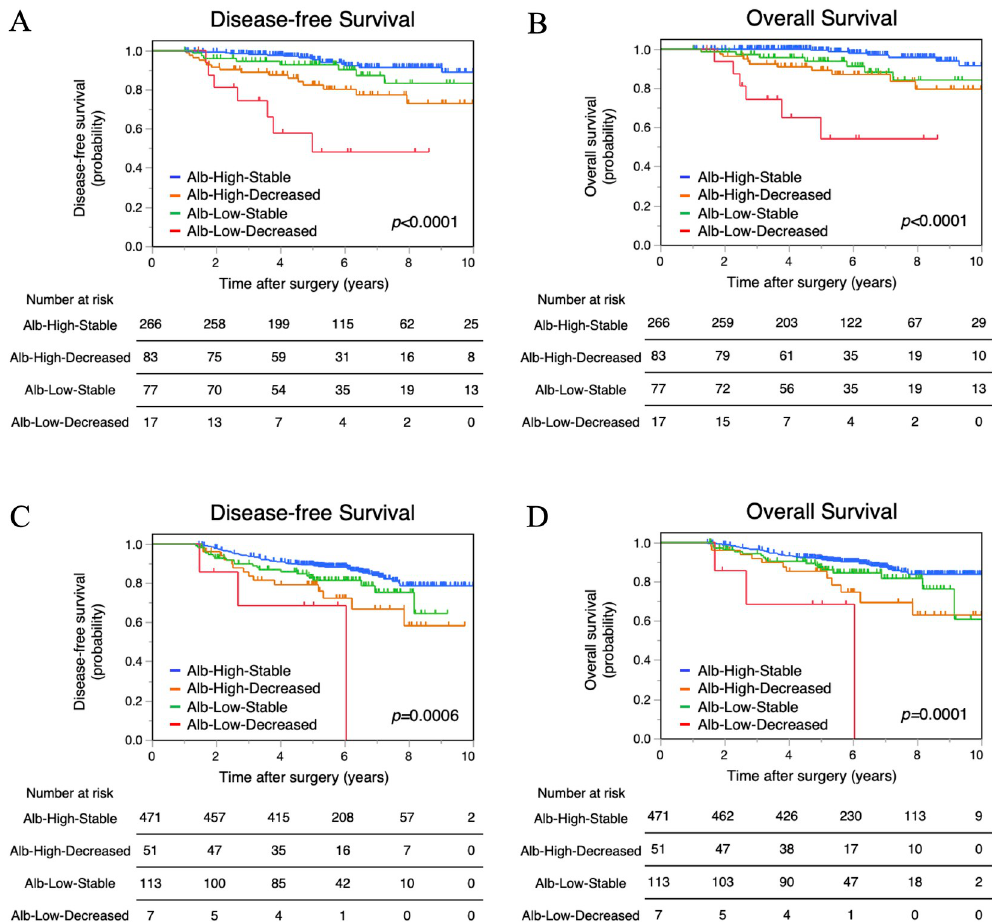
Fig 5. Combined survival analysis of preoperative serum albumin levels (preAlb) and postoperative decrease in serum albumin ( Δ Alb). Disease-free survival and overall survival of the Alb-Low-Decreased, Alb-Low-Stable, Alb-High-Decreased, and Alb-High-Stable groups in the training cohort (A, B) and in the validation cohort (C,